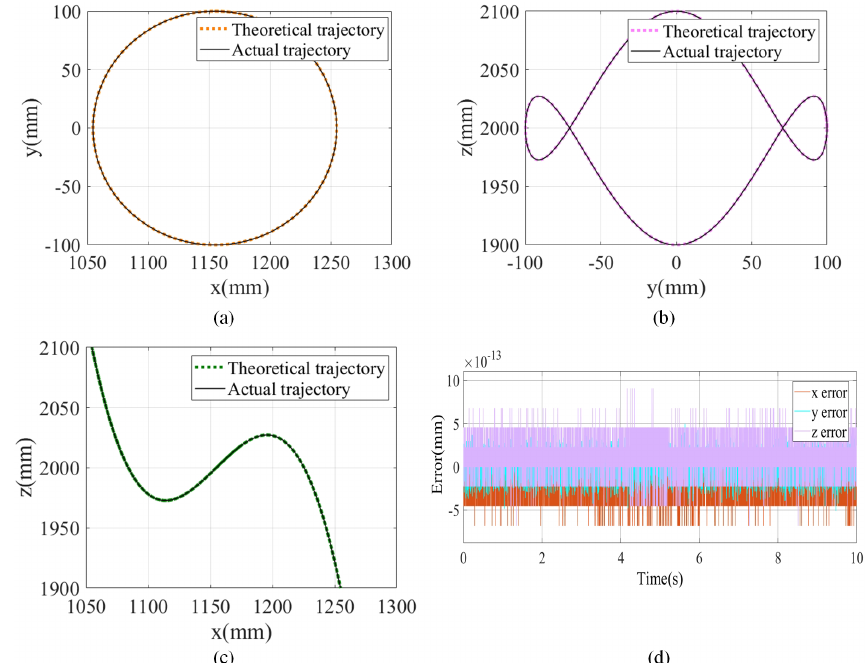
Figure 7. Projection and error of motion track on each